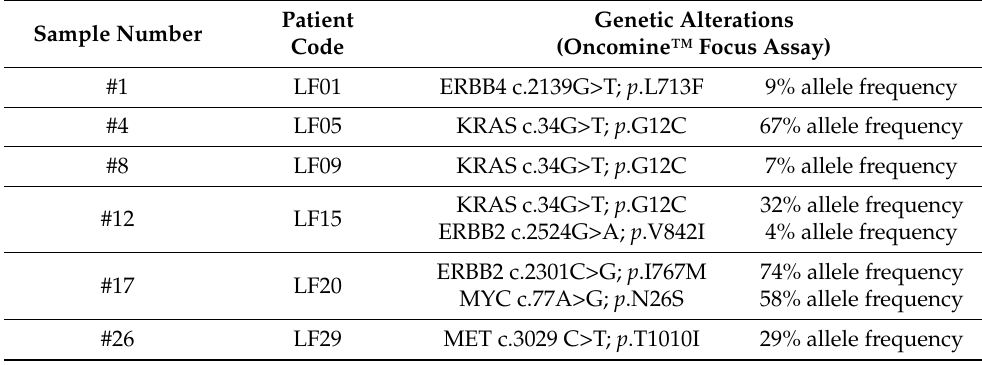
Table 3. Somatic mutation in surgically resected tumors that generated